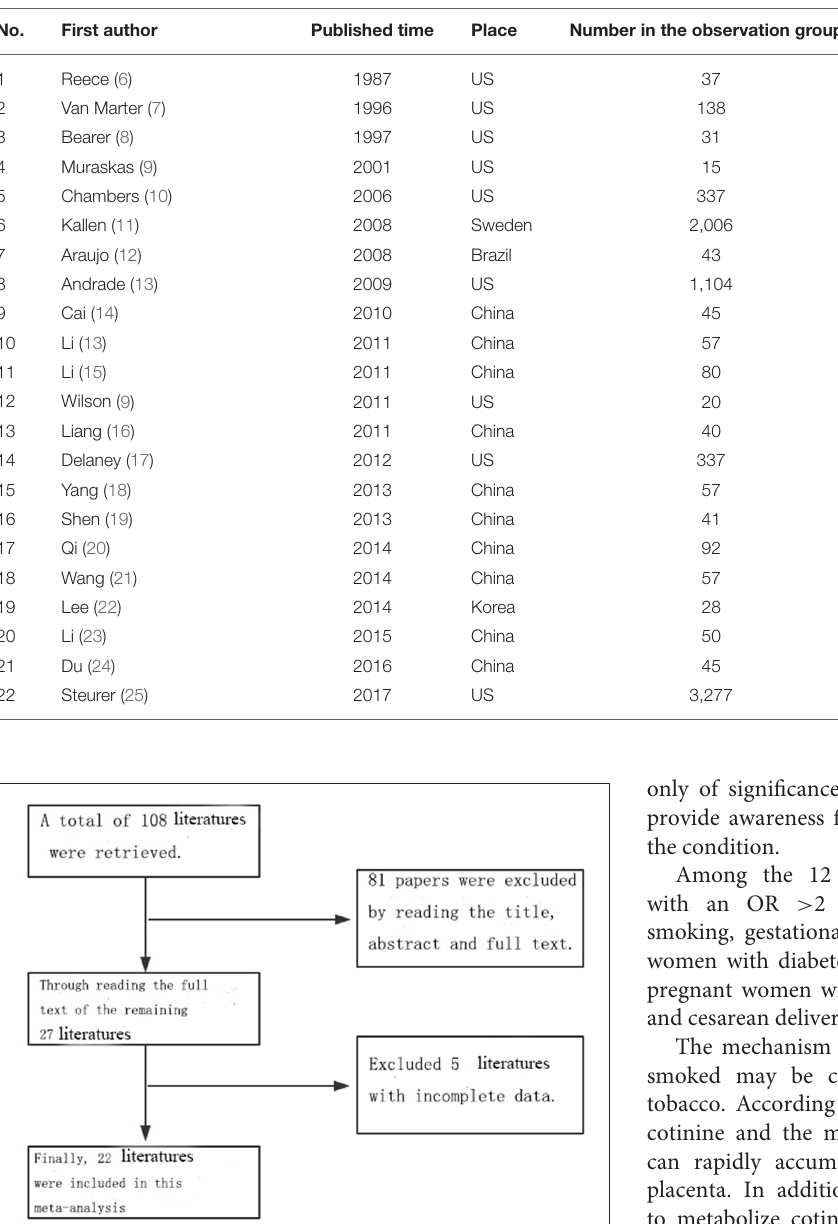
TABLE 1 | The basic situation of these literatures.